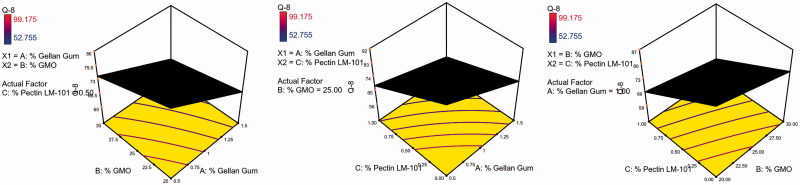
3D surface plot of GBP raft floating formulae after 8 h release in 0.1 N HCl.